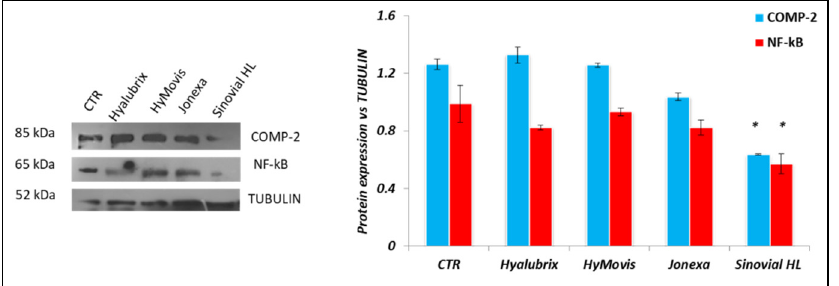
Figure 6. Evaluation of COMP-2 and NF-kB protein levels in pathological chondrocytes treated for 48 h with HA-based gels. Densitometric analysis was performed, normalizing COMP-2 and NF-kB protein expression with respect to TUBULIN: * p < 0.05. A t -test compared the significance of each treatment with respect to CTR.